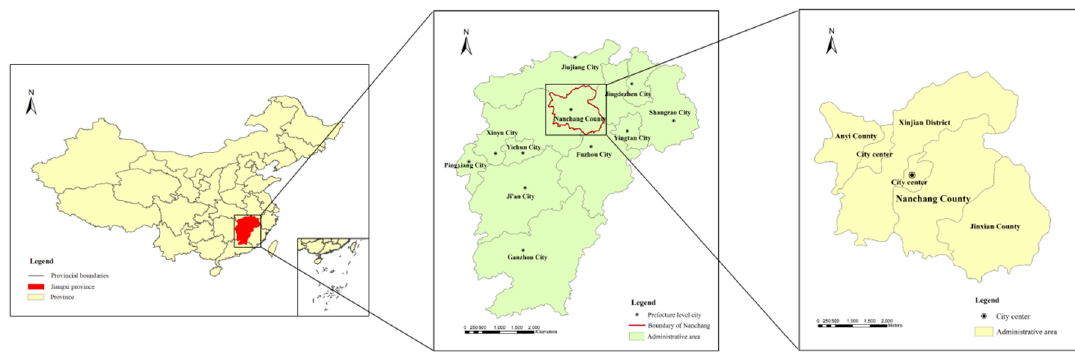
Figure 1. Location of Nanchang, Jiangxi province, China.